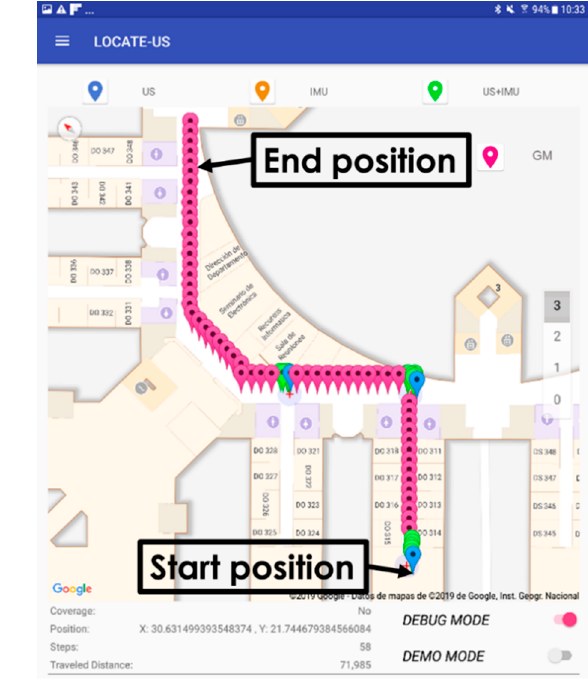
Sensors 2021 , 21 , x FOR PEER REVIEW 22 of 25 Figure 20. Cumulative distribution functions (CDFs) of distance errors related to the four experimental tests ( left ), comparing the IMU and the fusion (US + IMU) results, as well as a zoom for a distance error of 1m ( right ).